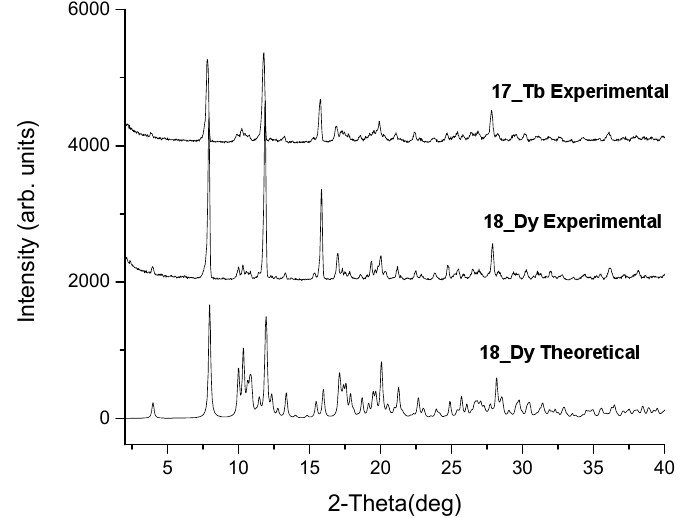
Figure 1. Experimental X-ray diffraction patterns of freshly prepared and well dried powders of complexes 17 _Tb and 18 _Dy. The simulated pattern of the structurally characterized Dy(III) complex 18 _Dy (labelled as 18_ Dy Theoretical) is also shown.